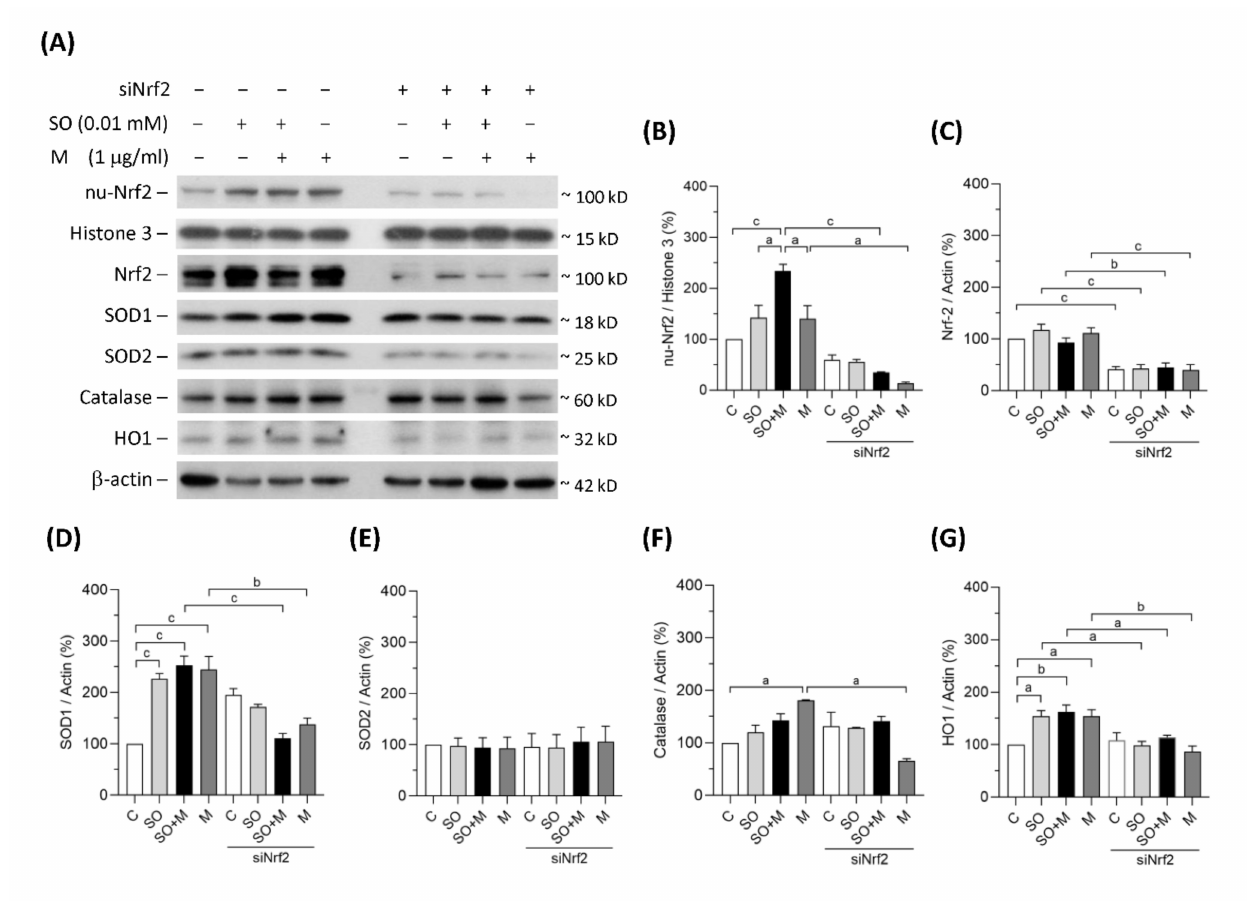
Figure 2. Protein expression of Nrf2 and antioxidants in HK-2 cells. ( A ) The representative immunoblot images for nuclear proteins of Nrf2 (nu-Nrf2) and histone 3, and total proteins of Nrf2, SOD1, SOD2, catalase, HO1, and β -actin. These protein expressions were detected by western blotting. ( B – G ) The quantified results of the blots. The cells were stimulated with 1 µ g/mL melamine (M) and/or 0.01 mM sodium oxalate (SO) for 6 h. C: control cells without treatment; siNrf2: the cells treated with Nrf2 small interference RNA for 24 h. Data are mean ± SE ( n = 3). a: p < 0.05; b: p < 0.01; c: p <